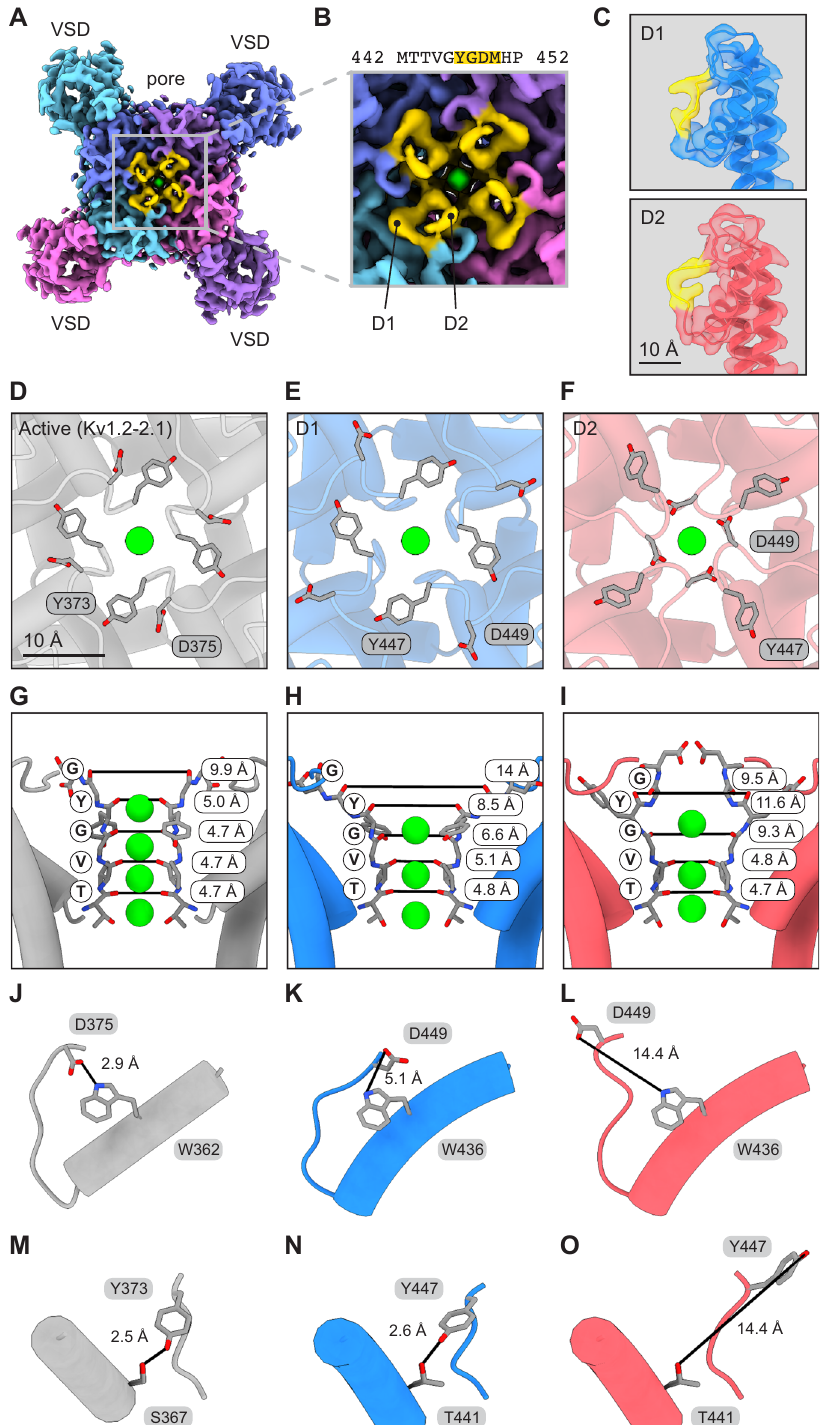
Fig. 2 The Kv1.3 selectivity fi lter adopts two distinct dilated conformations. A , B Kv1.3 cryo-EM map as viewed from the extracellular space with the D1 and D2 loop regions highlighted in yellow. A shows the entire extracellular surface of the channel and B shows a magni fi ed view of the pore region. C Cryo- EM maps for individual D1 and D2 subunits as determined by symmetry expansion and 3D classi fi cation. The maps are shown with models to highlight the different selectivity fi lter conformations. The region from Tyr447 to Met450 is highlighted in yellow. D – I Views of the pore for active state (Kv1.2-2.1, PDB 2R9R (Kv1.2-Kv2.1 structure)), D1 conformation, and D2 conformation. The pores are shown from the extracellular space ( D – F ) or from the side perspective ( G – I ). Distances between carbonyl oxygens of the TVGYG motif are reported and marked with black lines. J – O Asp and Trp residues ( J – L ) and Tyr and Ser/Thr residues ( M – O ) involved in hydrogen bonds that regulate C-type inactivation. Distances between hydrogen bonding partners are reported and marked with black lines. K + ions are shown in green in panels D – I